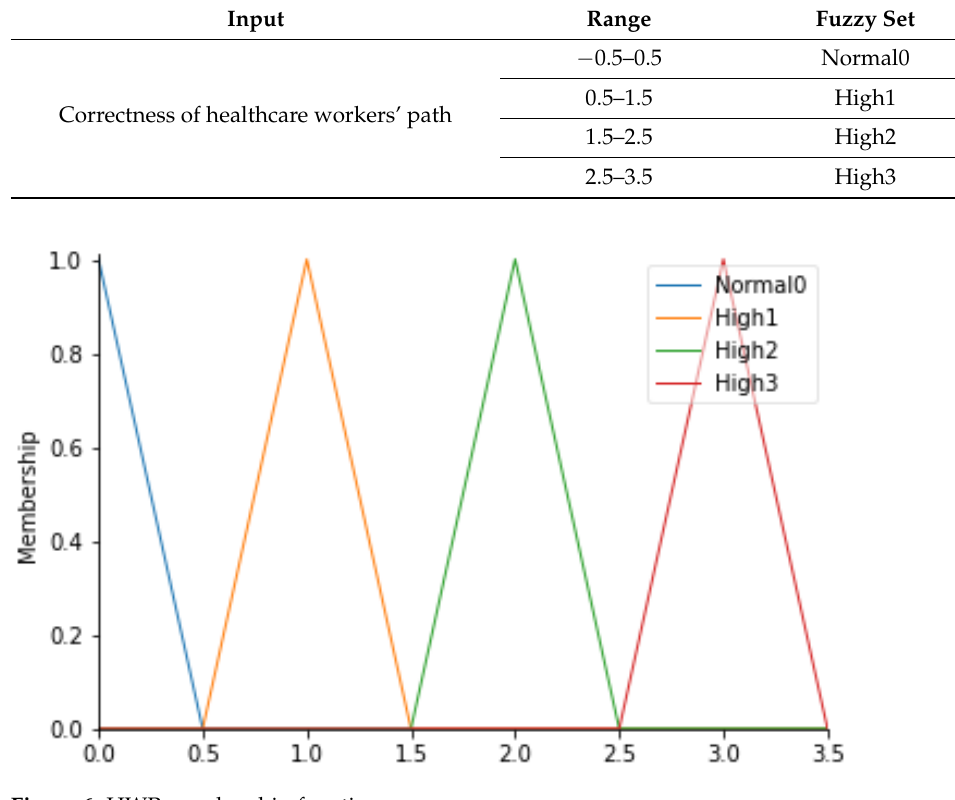
Figure 6. HWP membership functions.